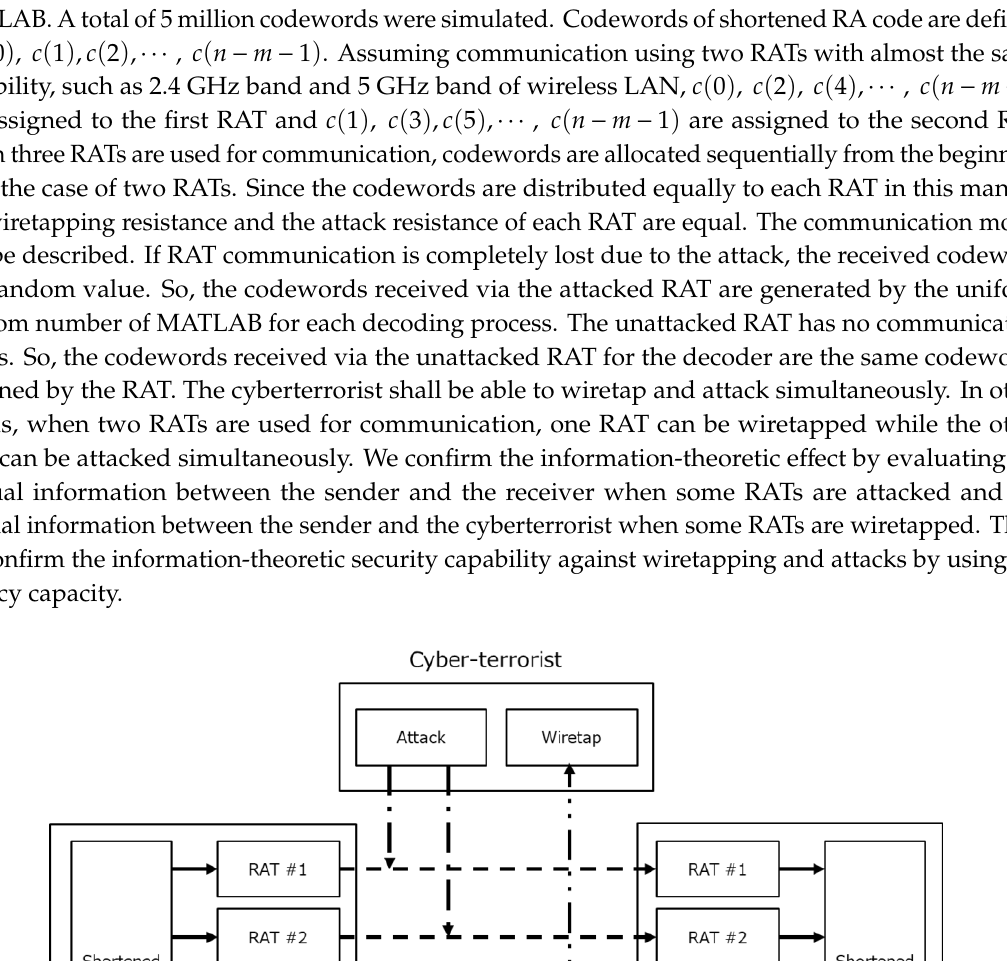
Table 3. Parameters of shortened RA code.